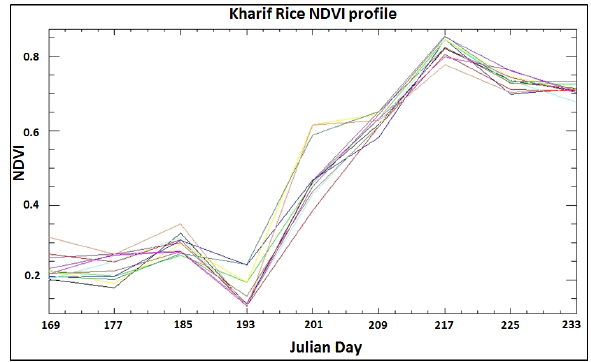
Figure 4: Kharif Rice NDVI Profiles for Uttar Pradesh The water stress was applied up to panicle initiation stage of the crop growth. Among the thirteen paddy states, maximum water stress was observed in Andhra Pradesh in the month of mid-July to end of crop season. While in other study states water stress varied from 0.76 to 1 in scale of 0-1, in which value 0 represent maximum stress and value 1 represent no stress. Image of LSWI and the corresponding water stress map for an 8 day period (from 13-20 August, 2018) has been depicted in Figure 5. The same trend was observed for other dates also.